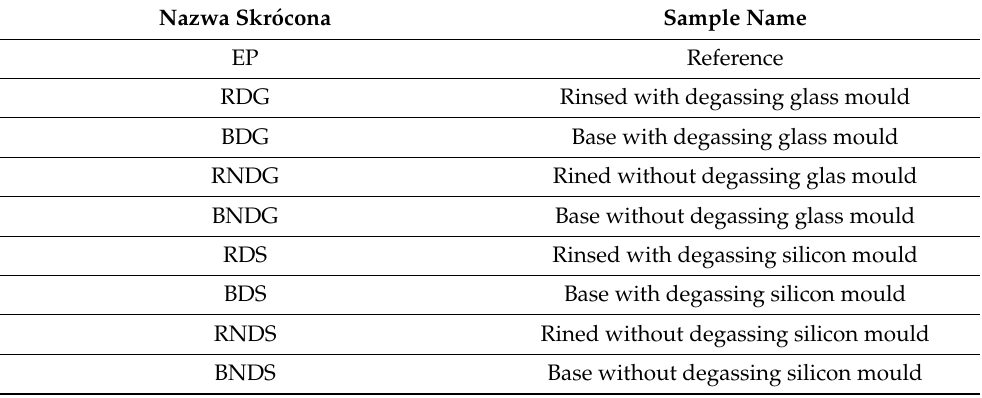
Table 1. Designations of the tested